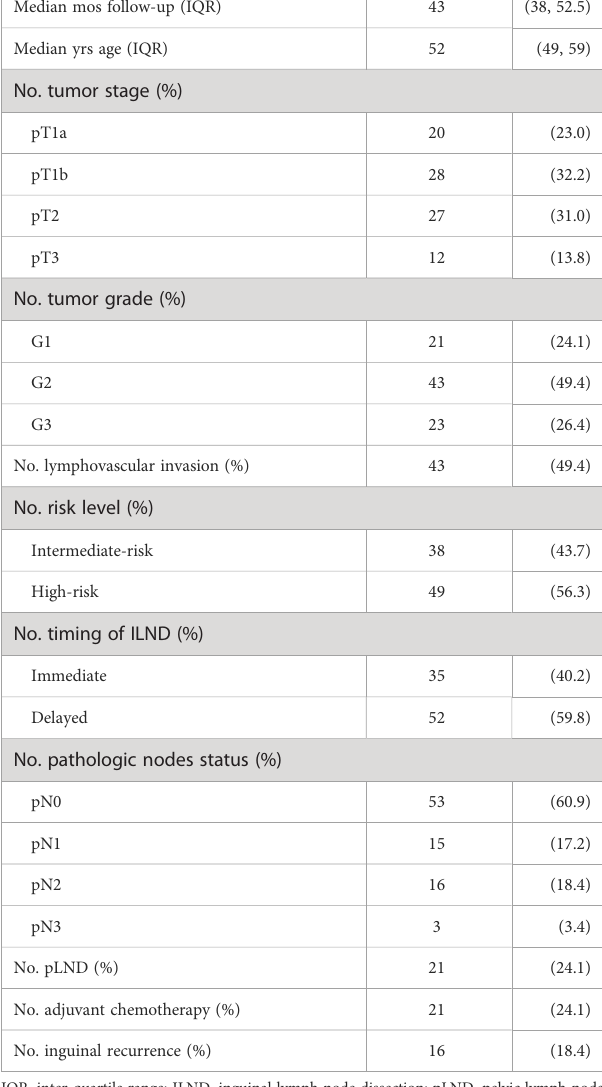
TABLE 1 Baseline patient and tumor characteristics in 87 cN0 penile cancer patients. Median mos follow-up